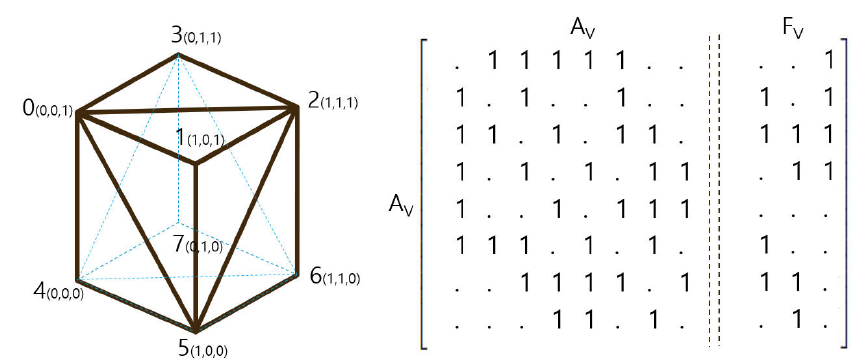
Figure 3. Vertex adjacency ( A V ) and vertex feature ( F V : position value of x/y/z) of a simple cube. Vertex*Face Adjacency ( A VF ). Since the geometry consists of a vertex and a face that shares the vertex, there is a limit to expressing the information using only the vertex adjacency. To solve this problem, a vertex*face adjacency ( A VF ) matrix was conceived so that the vertex and face information can be simultaneously configured. The column of the